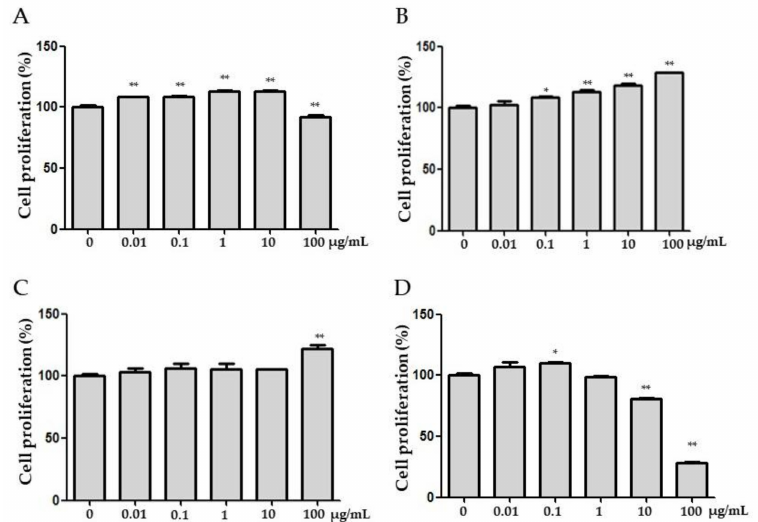
Figure 2. Proliferation activity in osteoblast MG63 cells. Effect of a variety concentration of ( A ) PE; ( B ) FPE; ( C ) DHD; ( D ) Equol on cell proliferation rate. * p < 0.05 compared to 0 µ g/mL, ** p < 0.01 compared to 0 µ g/mL. Data are means ± SEM of triplicates from one representative experiment.